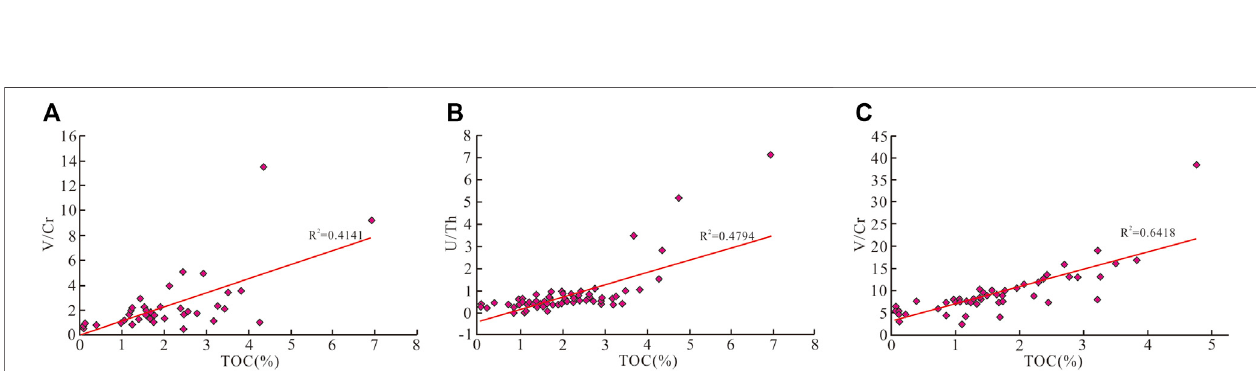
FIGURE 8 | Relationship between TOC content and V/Cr, U/TH, and Ni/CO in the study area.